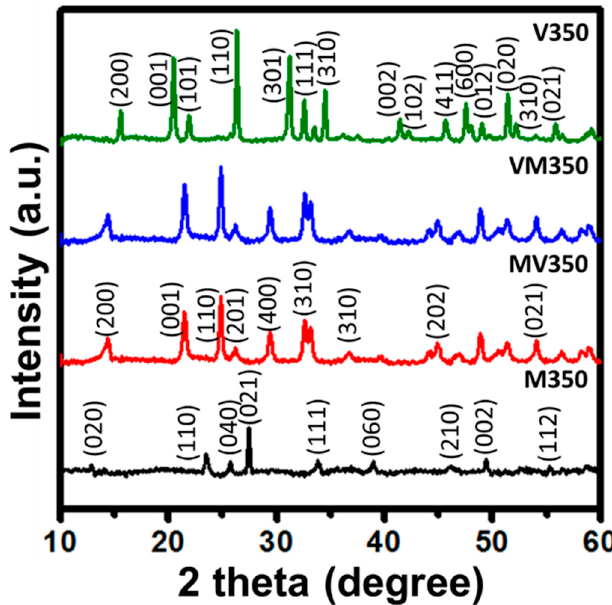
Figure 2. X-ray diffraction patterns of MoO 3 /V 2 O 5 hybrid nanobilayers heated at 350 °C for 2 h in air.